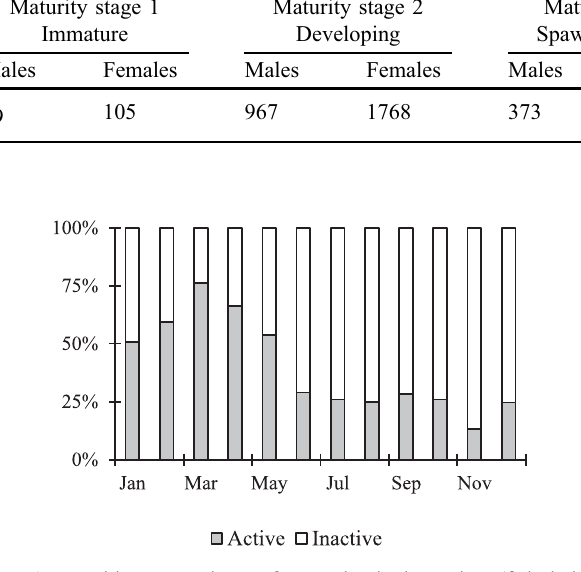
Fig. 4. Monthly proportions of reproductively active ( fi sh being capable of spawning within the current reproductive cycle) and inactive T. picturatus (sexually mature but reproductively inactive) from the Portuguese coast. Males and females were combined.